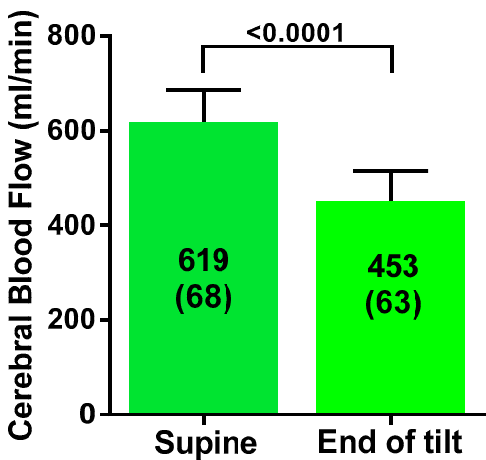
Figure 1. Cerebral blood flow in ml/min supine and at the end of a 20 degree tilt in severe ME/CFS patients.